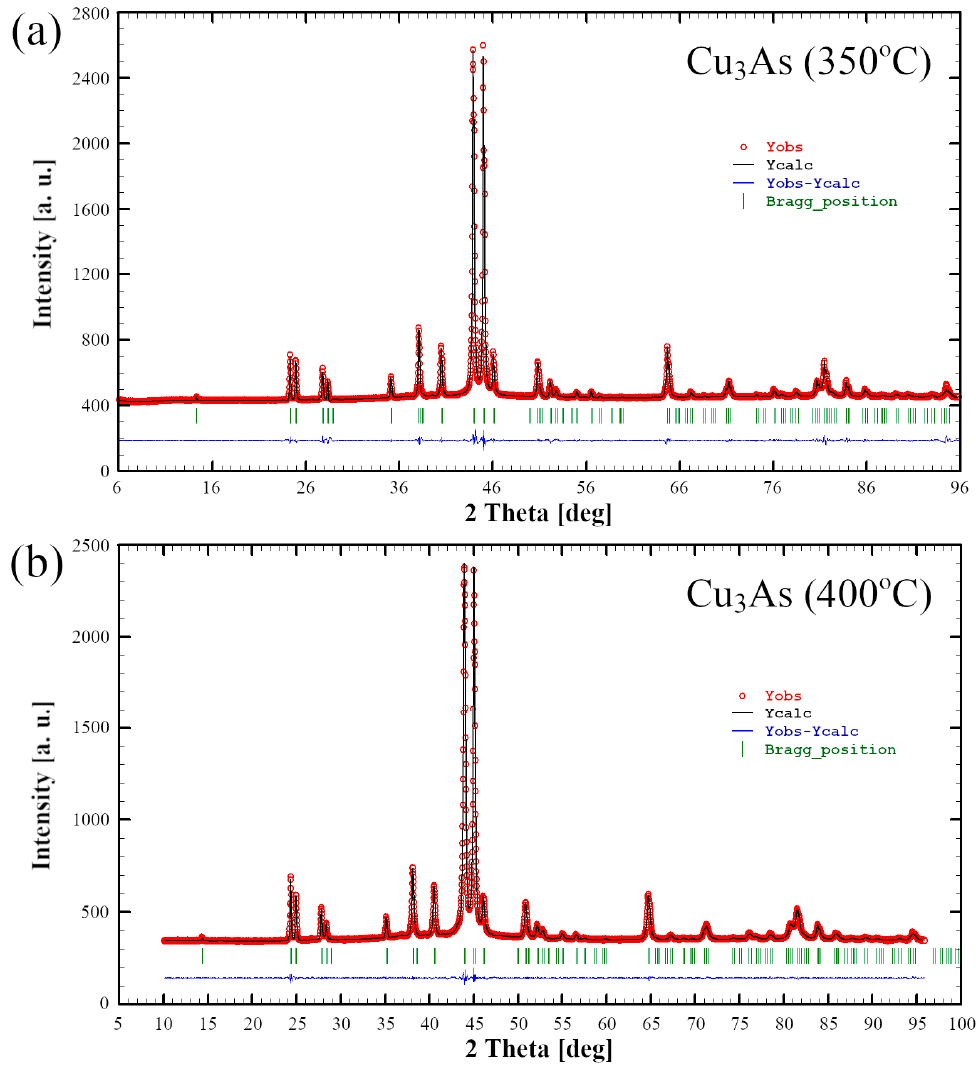
Figure 8. Rietveld refinement profiles (black line) obtained for the Cu 3 As samples 350 °C—13 days ( a ) and 400 °C—14 days ( b ). The observed powder patterns are highlighted in red. The lower profile (blue line) gives the difference between observed and calculated data; the Bragg angle positions are indicated by vertical bars (green).